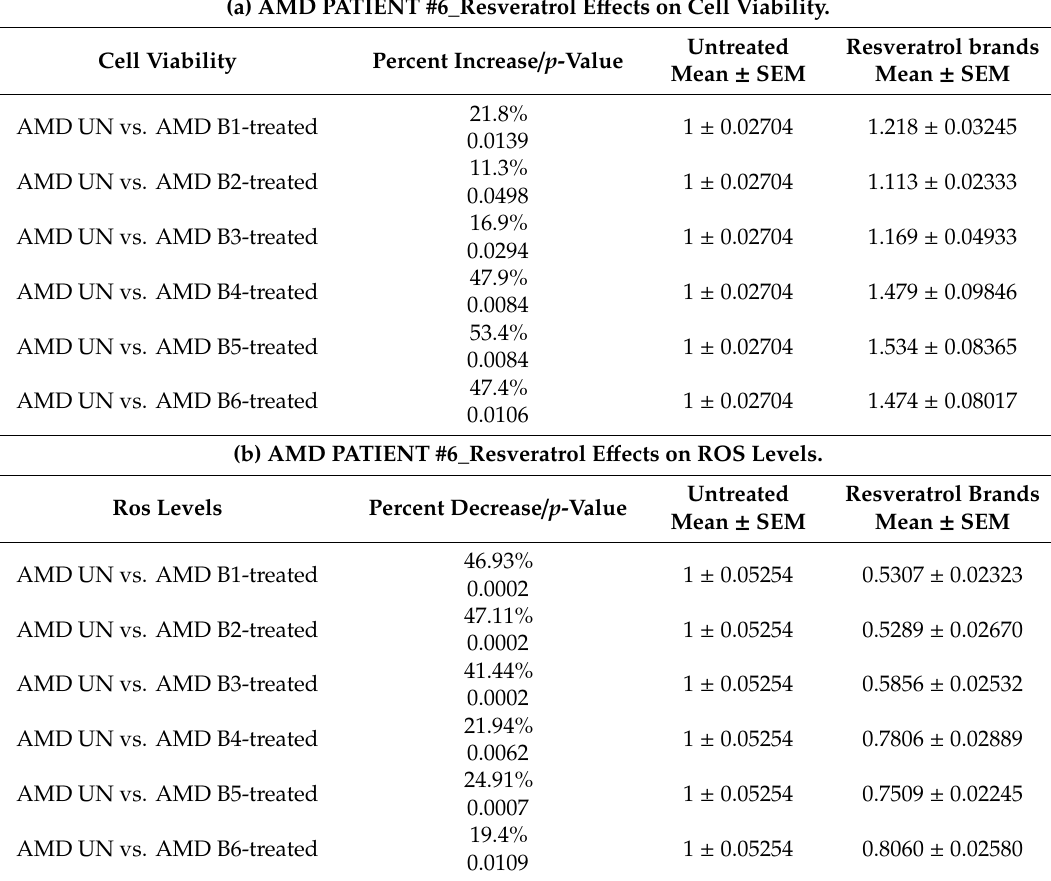
Table 8. E ff ects of resveratrol formulations on cell viability ( a ) and ROS levels ( b ) in AMD patient # 6. (a) AMD PATIENT #6_Resveratrol E ff ects on Cell